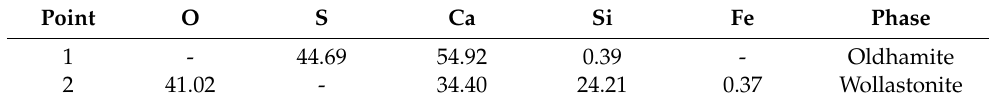
Table 6. Chemical composition of points indicated in Figure 10 (wt%).